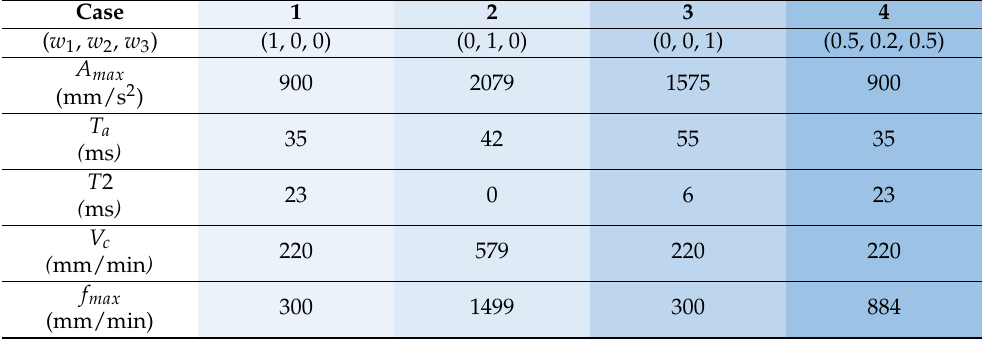
Table 5. Results for optimized interpolation parameters according to the optimized mode.